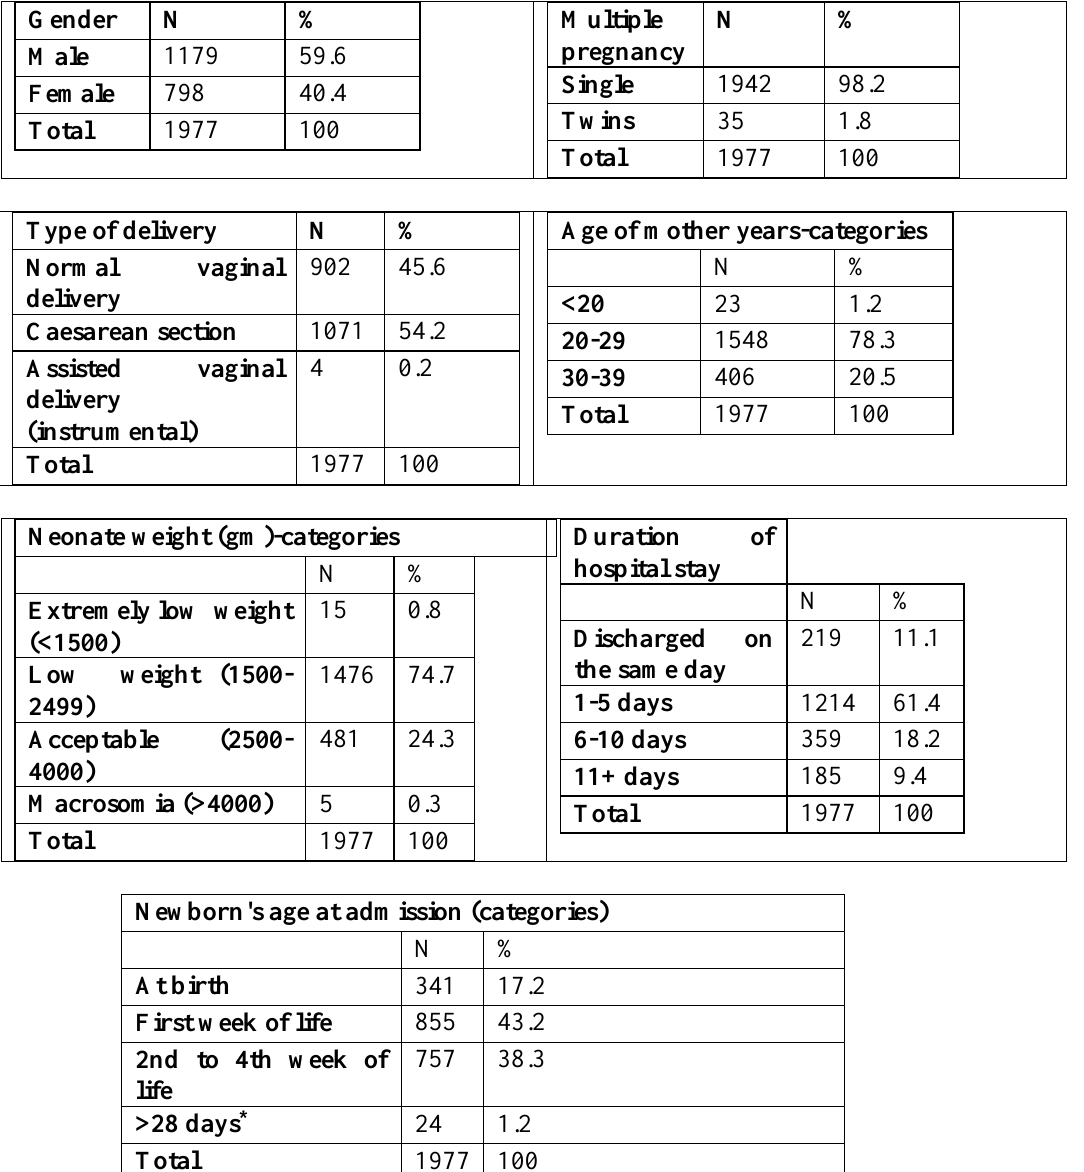
Table 1: Frequency distribution of the study sample by socio-demographic variables